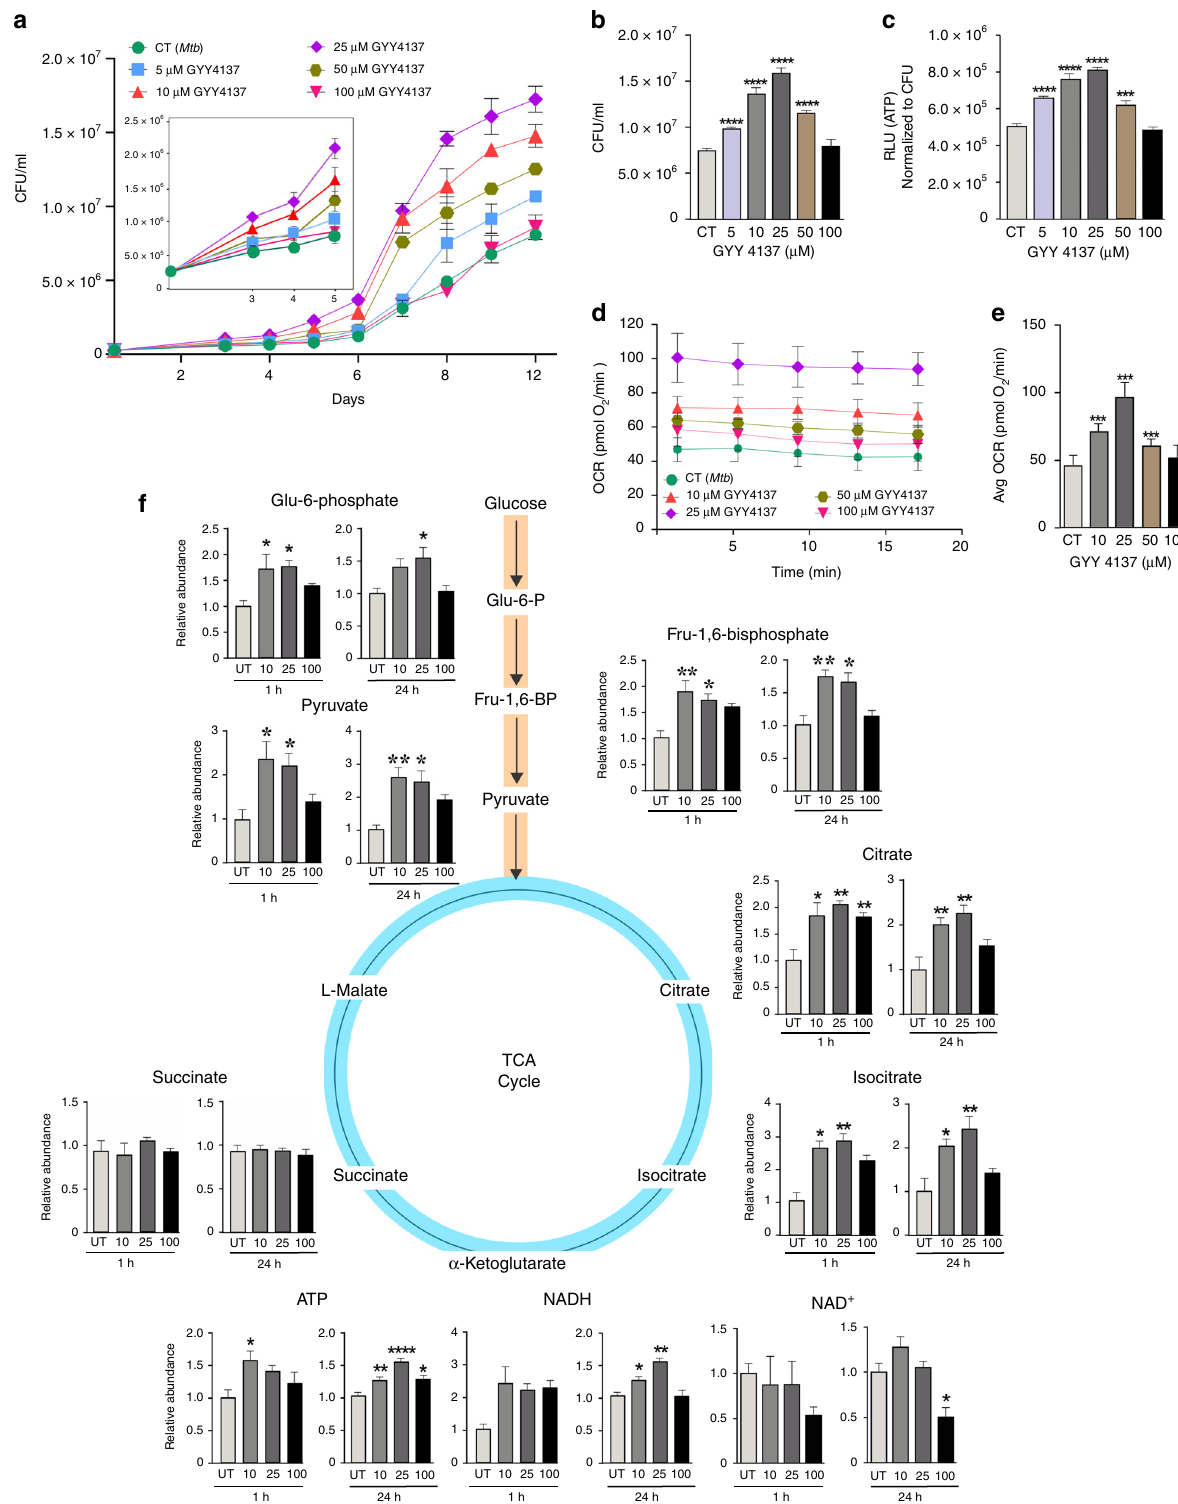
Fig. 2 GYY4137 modulates Mtb growth, bioenergetics and ATP production. a CFU-based growth pro fi le of Mtb following incubation with GYY4137. Inset shows early Mtb growth. b Mean CFU values at day 12 of the growth analysis. c ATP levels in Mtb following 24 h exposure to GYY4137. Data ( a − c ) are representative of at least two independent experiments. d OCR pro fi le ( n = 4 − 6) and e average OCR of Mtb exposed to GYY4137 ( n = 20 − 30). Control (CT) groups in panels ( a − e ) received spent GYY4137. f LC-MS targeted metabolic analysis of Mtb with or without exposure to 10, 25 and 100 μ M GYY4137 (for 1 or 24 h). Graphs show relative abundance (peak area) of metabolites in Mtb cells ( n ≥ 3 per group). Data are shown as mean ± SD, except ( b ) and ( f ) (mean ± SEM). Data in ( a ) were analyzed using two-way ANOVA with Tukey ’ s multiple comparisons test, with day 12 data shown in ( b ), or one-way ANOVA ( c − f ) with Sidak ’ s multiple comparisons test. All statistical differences are relative to untreated controls. * P < 0.05, ** P < 0.01, *** P < 0.001, and **** P < 0.0001. Source data are provided as a Source Data fi